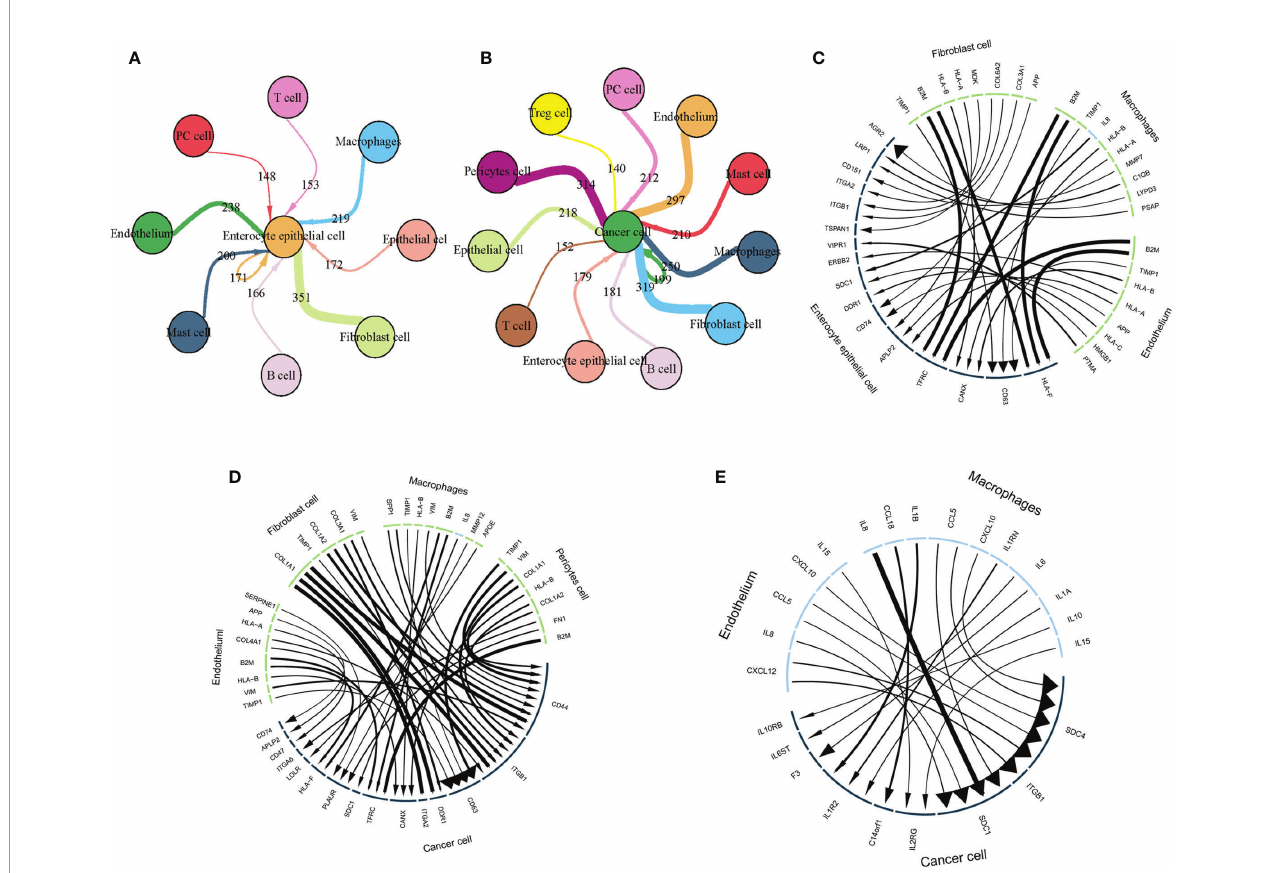
FIGURE 8 | TME interacts with intestinal epithelial and cancer cells via L-R. (A) The TME interacts with intestinal epithelium cells via L-R interactions. Circle size represents cell counts, line and arrow size represents interaction counts; larger sizes re fl ect more counts and interactions with each other. (B) The TME interacts with cancer cells via L-Rs. Circle size represents cell counts and line size represents interaction counts. A larger size means more counts and interactions with each other. (C) The strongest 10 L-R pairs showing interactions between fi broblasts, macrophages, and endothelial cells with intestinal epithelial cells. Line and arrow size represents interaction counts. (D) The strongest 10 L-R pairs showing interactions between fi broblasts, macrophages, and endothelial cells with cancer cells. Line and arrow size represents interaction counts. (E) Macrophages and endothelial cells interact with cancer cells via cytokines. Line and arrow size represents interaction